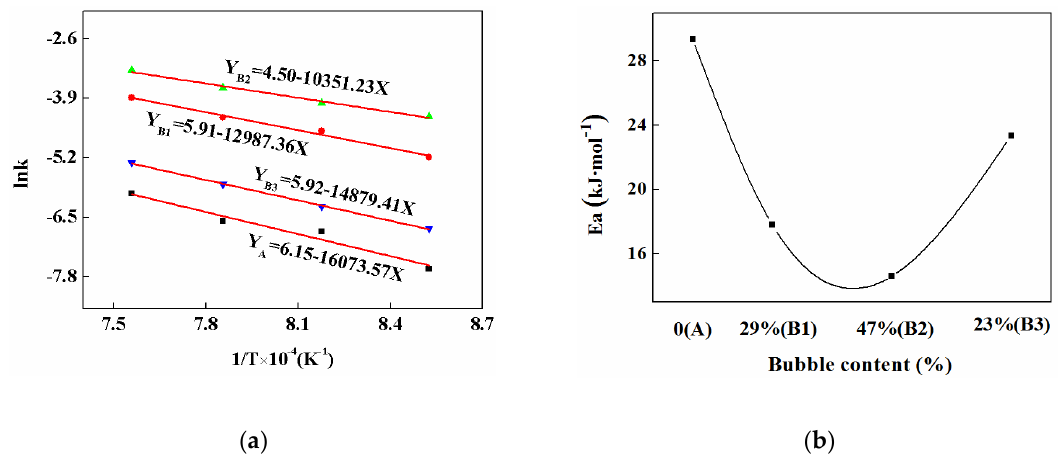
Figure 11. Plots of ln k vs. 1/ RT for mold fluxes ( a ) and Ea of the four series of mold fluxes ( b ).